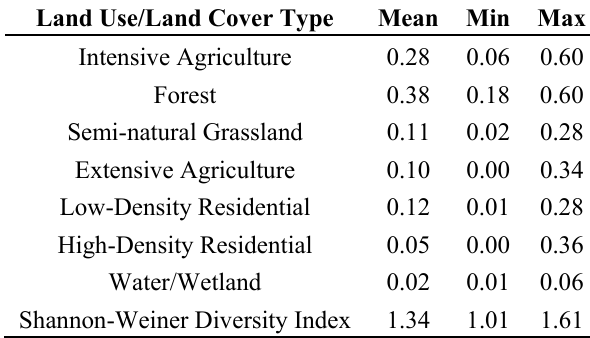
Table A2. Composition of land cover types surrounding 10 conservation grasslands in southwest Ohio, USA. Values are proportions of the total area within 740 m of the center of study transects within grassland